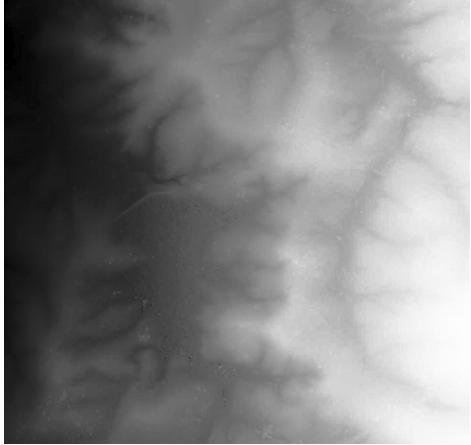
Figure 6. Interferogram with the Unwrapped Phase